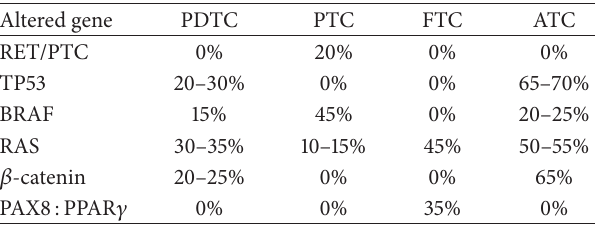
Table 1: Prevalence of genetic alterations in patients with various thyroid